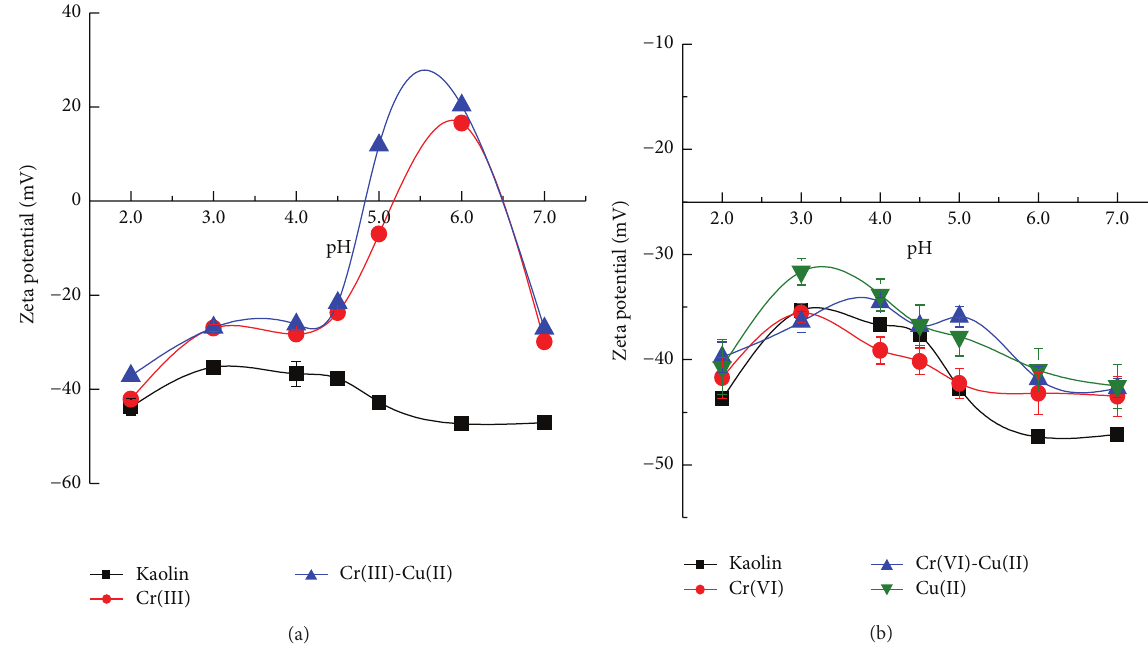
Figure 6: The zeta potential curve for original kaolin and kaolin after adsorbed Cr(III) (a) or Cr(VI) (b) in absence and presence of Cu(II).